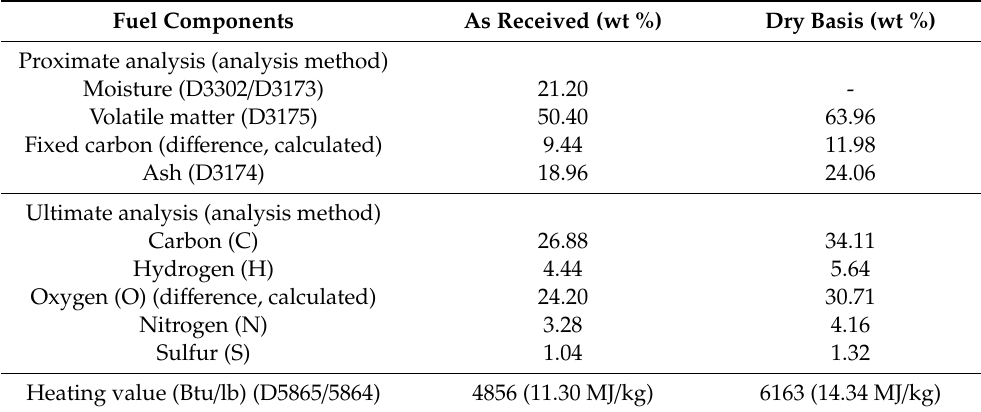
Table 2. Proximate and ultimate analysis of poultry litter